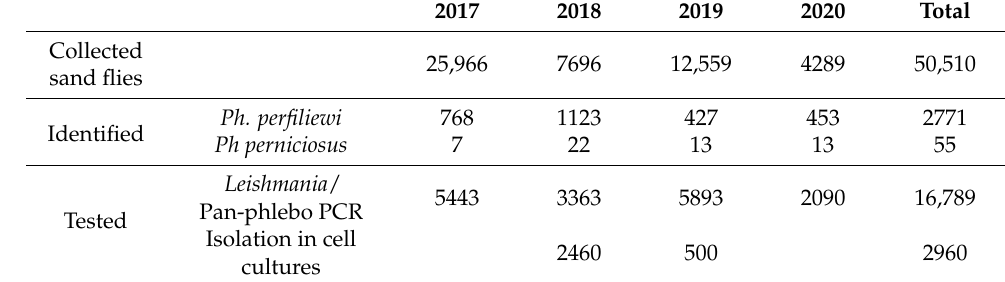
Table 1. Collection, testing, and identification of sand flies during the years of surveillance.